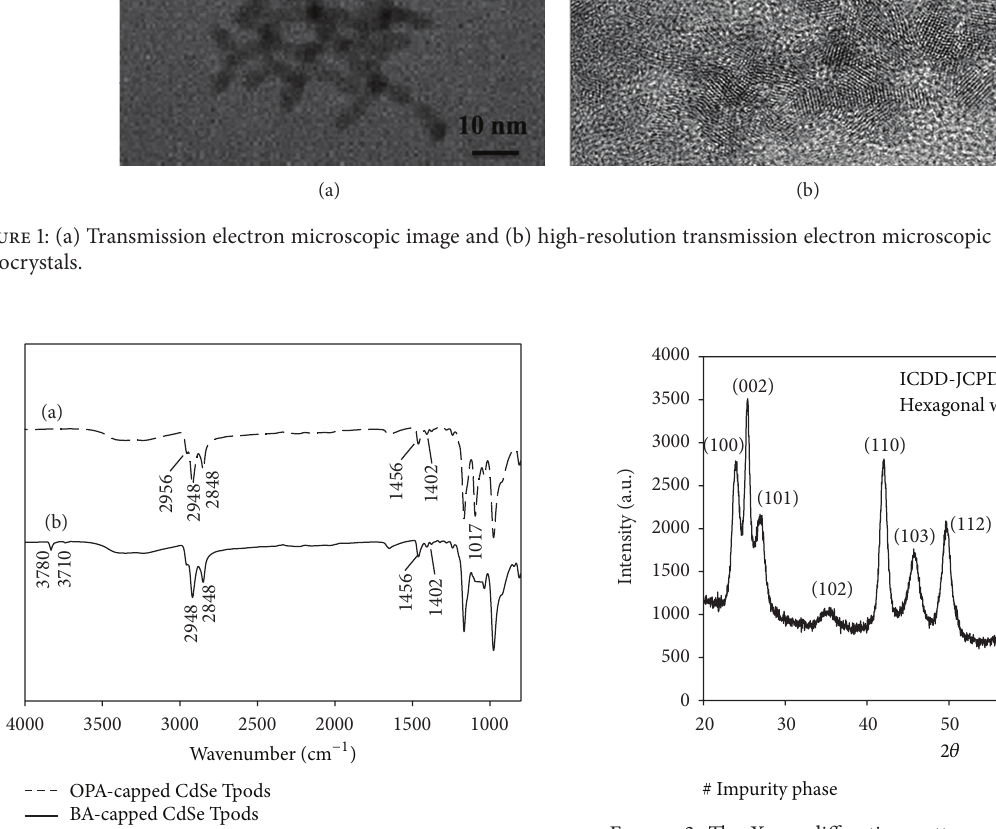
Figure 2: FT-IR spectra of (a) OPA-capped CdSe tetrapods (Tpods) and (b) BA-capped CdSe Tpods.